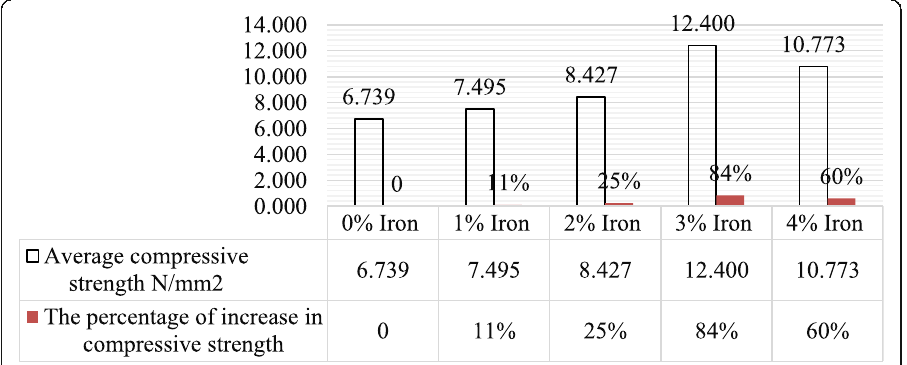
Fig. 15 Average compressive strength testing